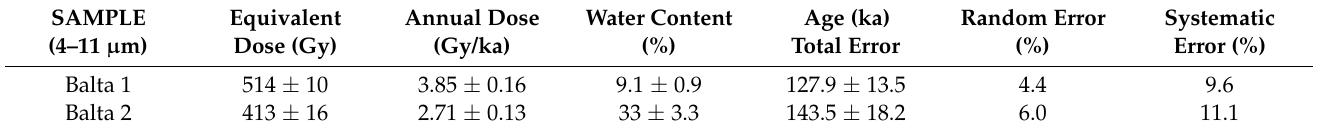
Table 3. Results of optically stimulated luminescence